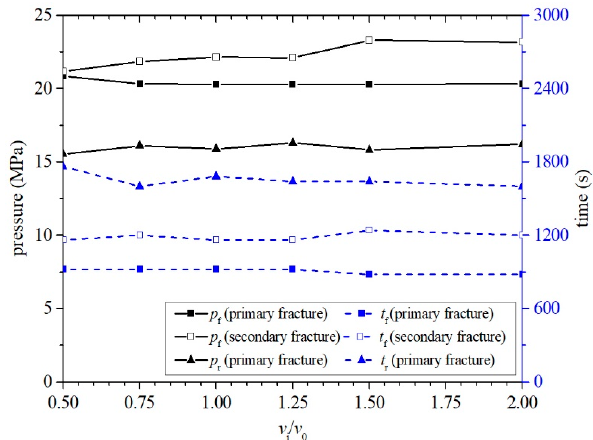
Figure 11. The breakdown pressure/time and reopening pressure/time of fractures in models with different interlayer Poisson’s ratio. di ff erent interlayer Poisson’s